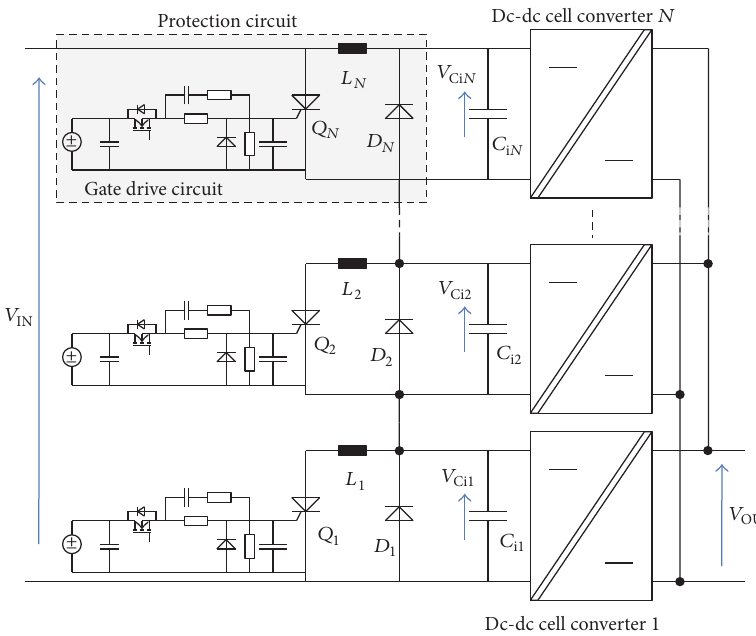
Figure 3: ISOP multicell dc-dc converter and conventional protection circuit.